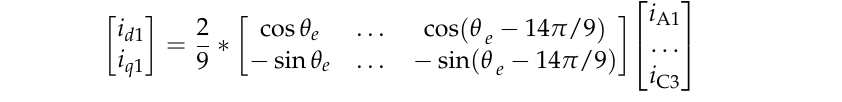
Figure 2. Diagram of diagnosis and tolerant control of nine-phase PMSM